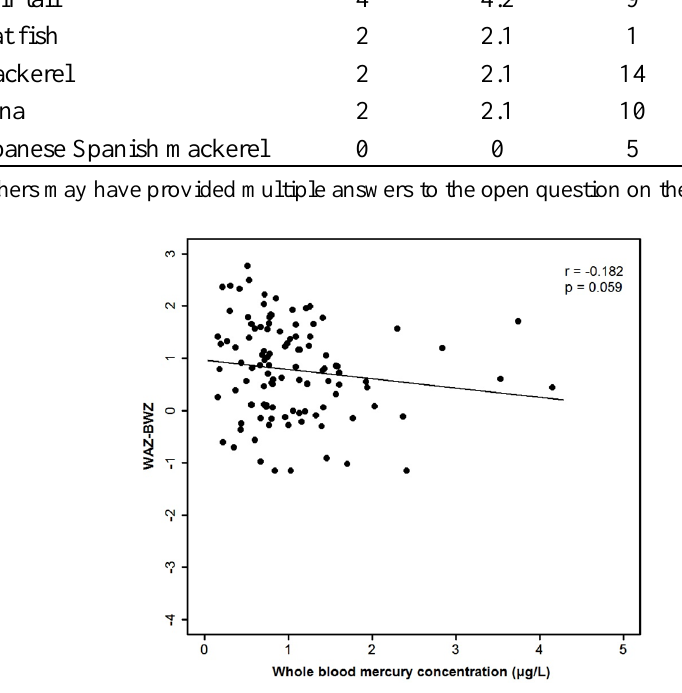
Figure S1. Correlation between whole blood mercury content and WAZ-BWZ.